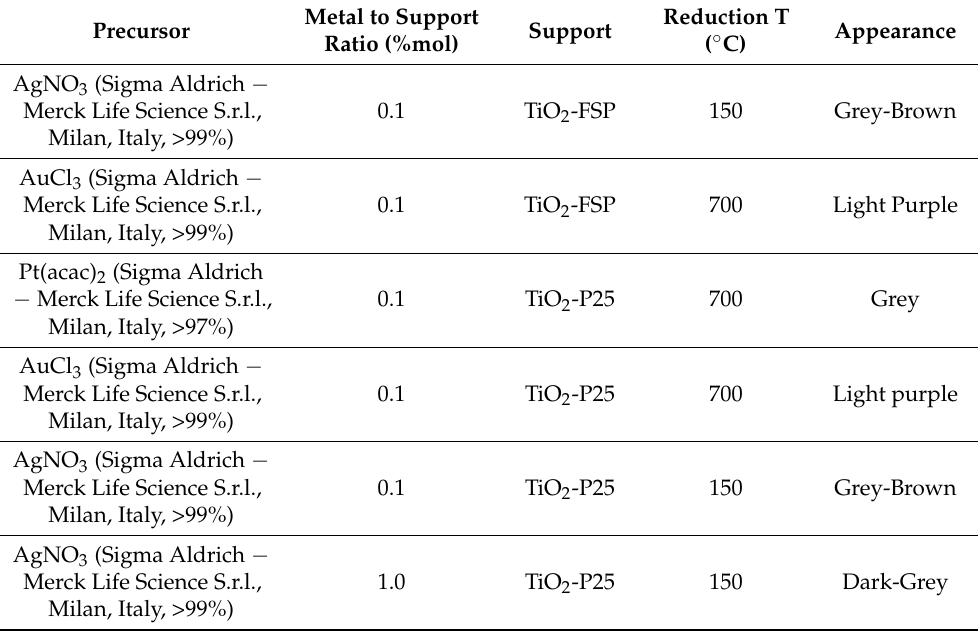
Table 2. Details for preparation of each catalyst through wet